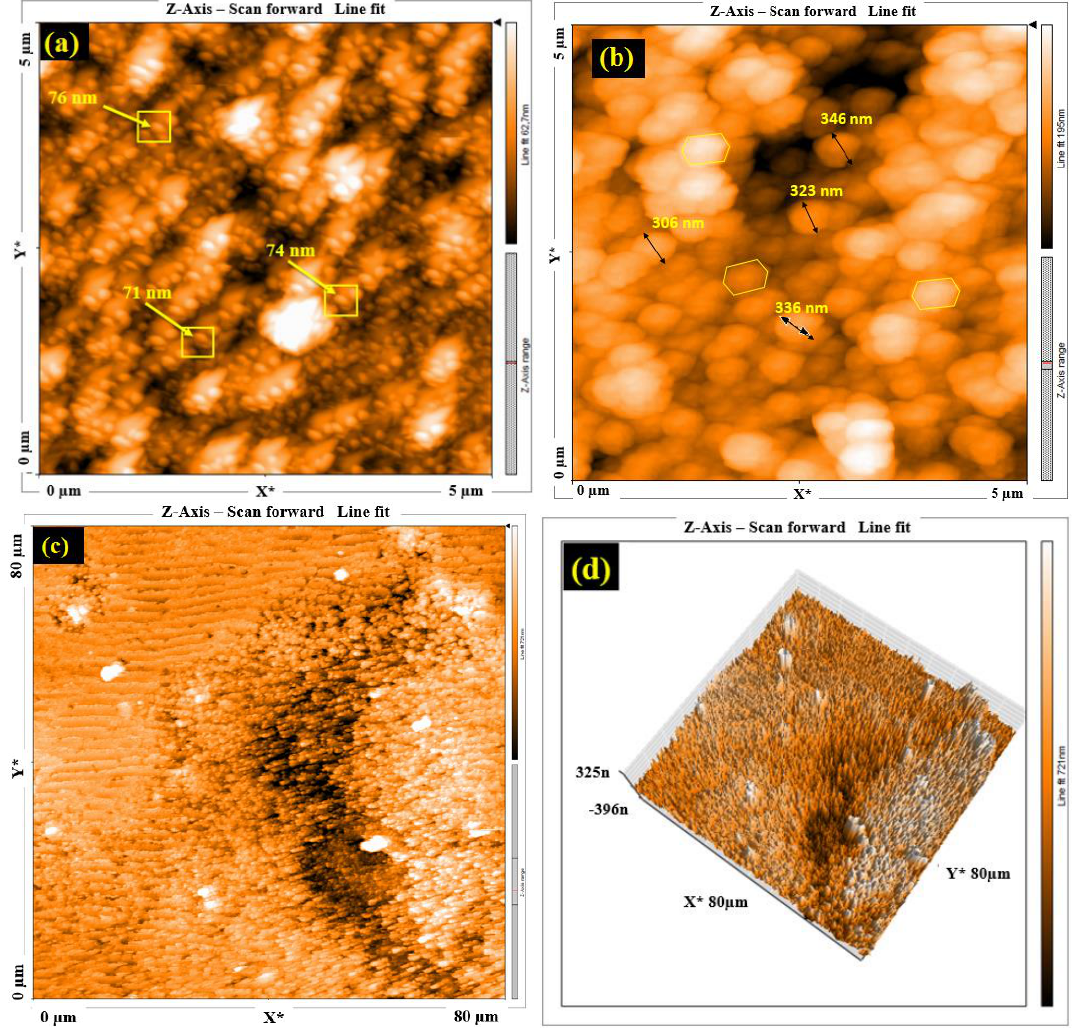
Figure 8. Two/three-dimensional images of Au-diazo-ZnO NPs and Au-diazo-ZnO NRs. ( a ) Figure8. Two / three-dimensionalimagesofAu-diazo-ZnONPsandAu-diazo-ZnONRs. ( a )Au-diazo-ZnO Au-diazo-ZnO NPs with NPs diameter on (5 × 5 µm 2 ) image, ( b ) NRs diameter on (5 × 5 µm 2 ) image, NPs with NPs diameter on (5 × 5 µ m 2 ) image, ( b ) NRs diameter on (5 × 5 µ m 2 ) image, ( c ) (80 × 80 µ m 2 ) ( c ) (80 × 80 µm 2 ) 2D image of Au-diazo-ZnO NRs and ( d ) (80 × 80 µm 2 ) 3D image of Au-diazo-ZnO 2D image of Au-diazo-ZnO NRs and ( d ) (80 × 80 µ m 2 ) 3D image of Au-diazo-ZnO NRs.